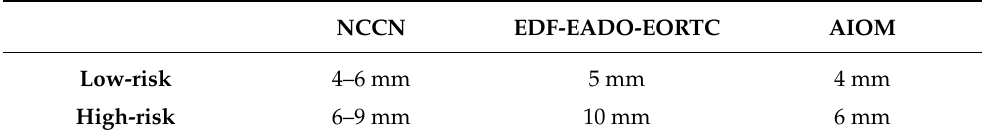
Table 5. Minimum safety margins recommended by the NCCN, EDF-EADO-EORTC, and AIOM for the surgical treatment of low- and high-risk cutaneous squamous cell